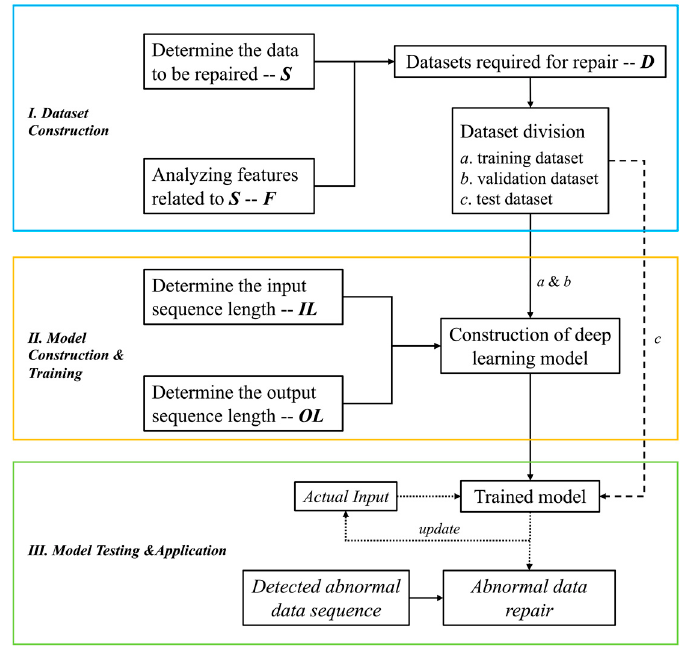
Figure 1. The process framework of drainage system monitoring data repair.